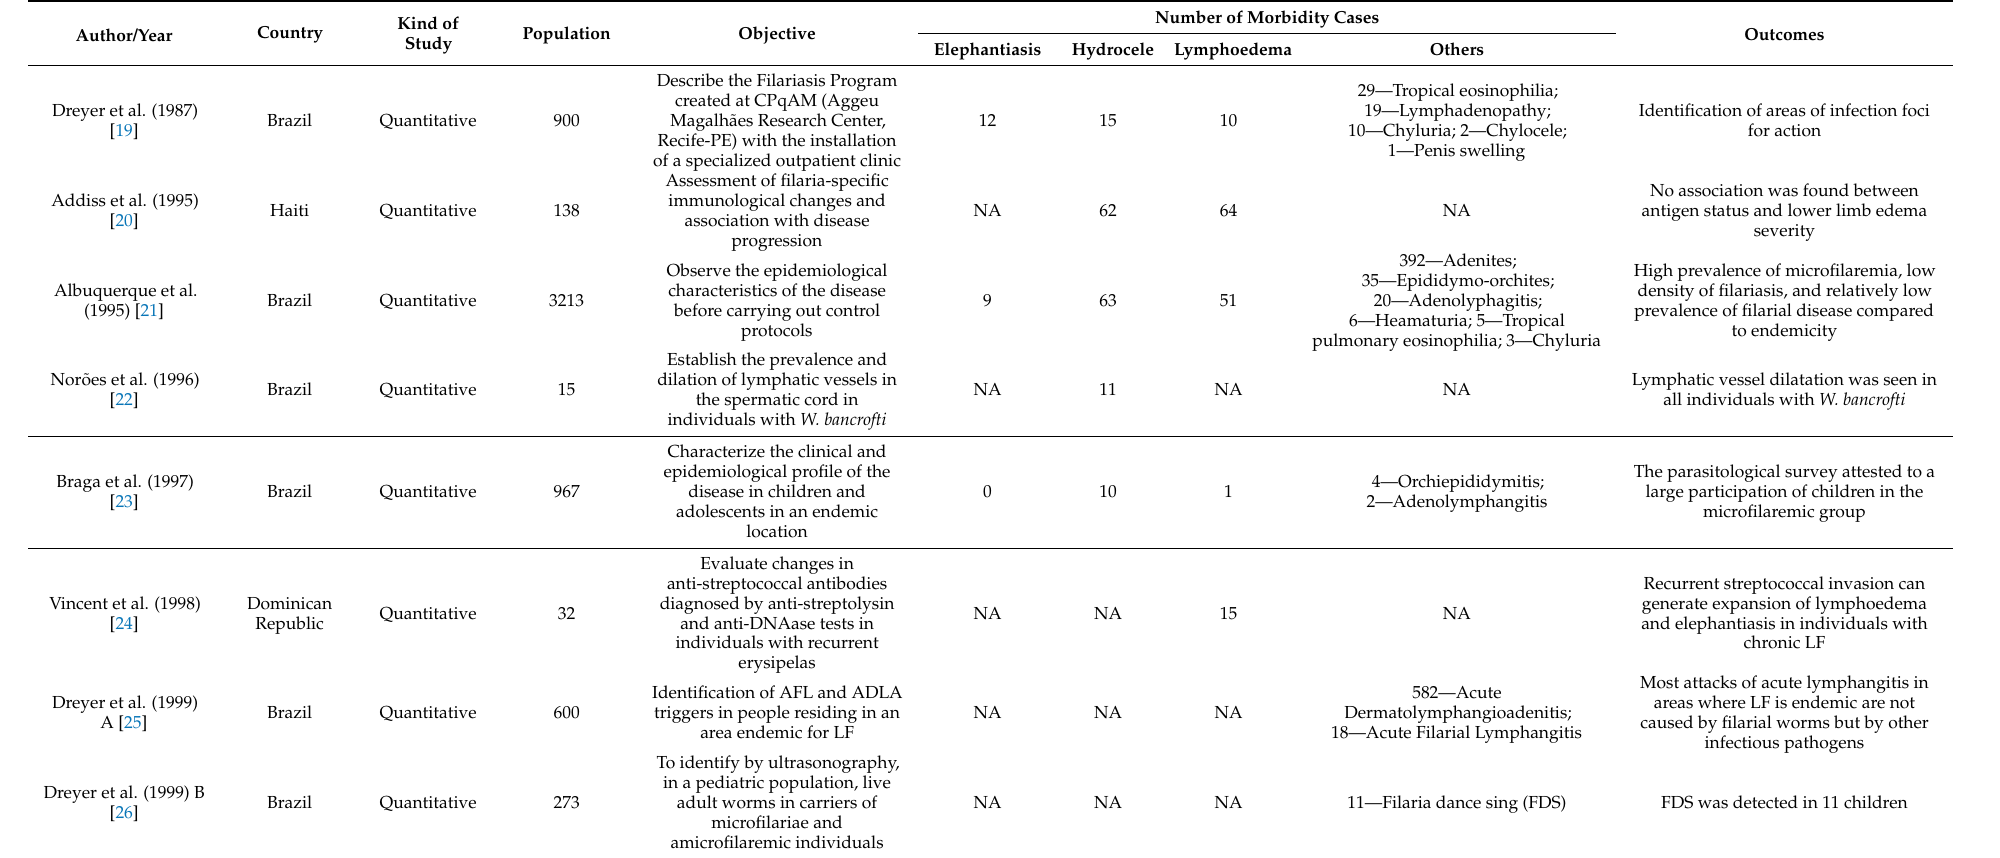
Table 1. Details of data extracted from quantitative